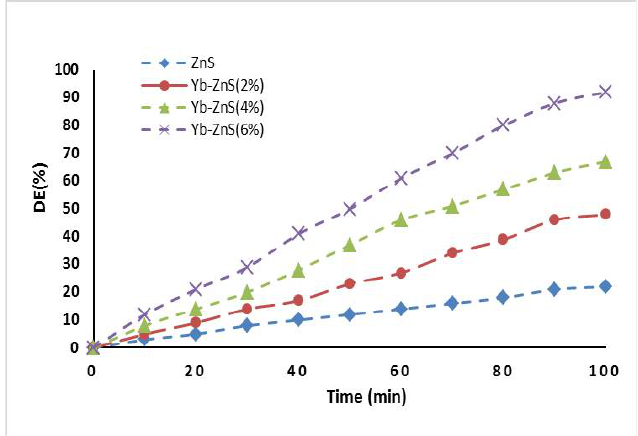
Fig. 6. The effect of Yb 3+ dopant content on the decolorization of 10 mg/L Yellow 5 (catalyst loading 1.0 g/L)